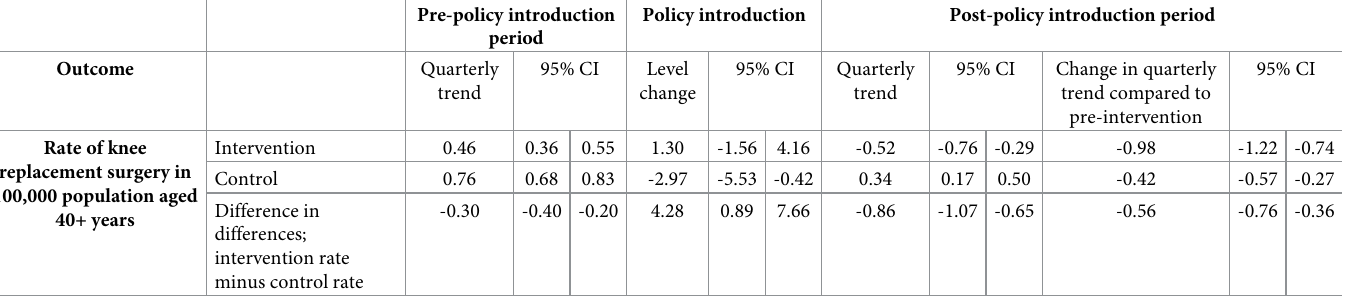
Table 1. Interrupted time series segmented linear regression and difference in difference analyses before and after policy introduction in intervention and control CCGs.